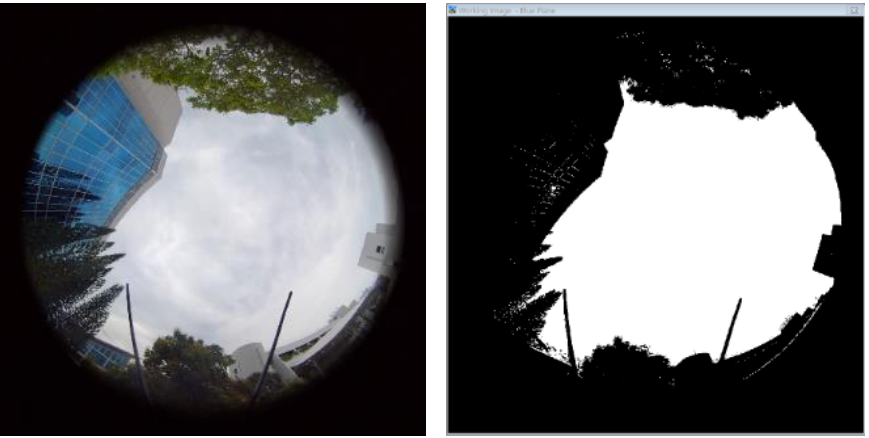
Figure 12. ( Left ) Photo before Process; ( Right ) Photo after applying Blue Filter and Threshold Value. As the photo exports and position logs are only available in 1 s intervals, interpolations are needed to match the EPH and horizontal uncertainty with the location at which the photo was taken. Therefore, the sensitivity of the sky openness ratio to minor variation in position would need to be investigated; an additional photography session was conducted at ground level (~2 m AGL) near N3.1 (Figure 13) with a distance interval of 1 m along the road divider line, and the resulting sky openness ratios from Figure 13a–c are 17.98%, 17.63% and 17.47%, respectively. Therefore, it could be assumed that linear interpolation of location coordinates using nearby data at ± 1m (or one flight log interval) away would not result in significant altercation to the correlation between horizontal position error and sky ratio for that photo point.